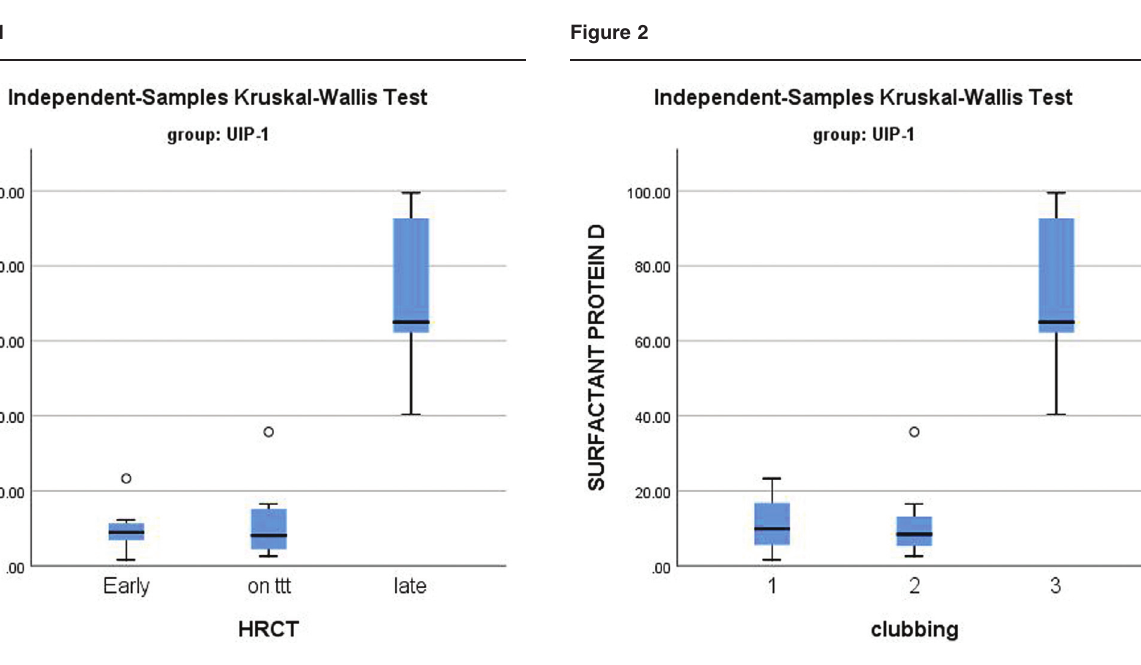
The relation between the serum level of surfactant protein-D and degree of